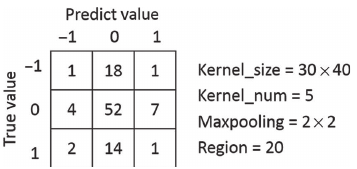
Figure 14: Confusion Matrix of Experiment 1 in Architecture 2.